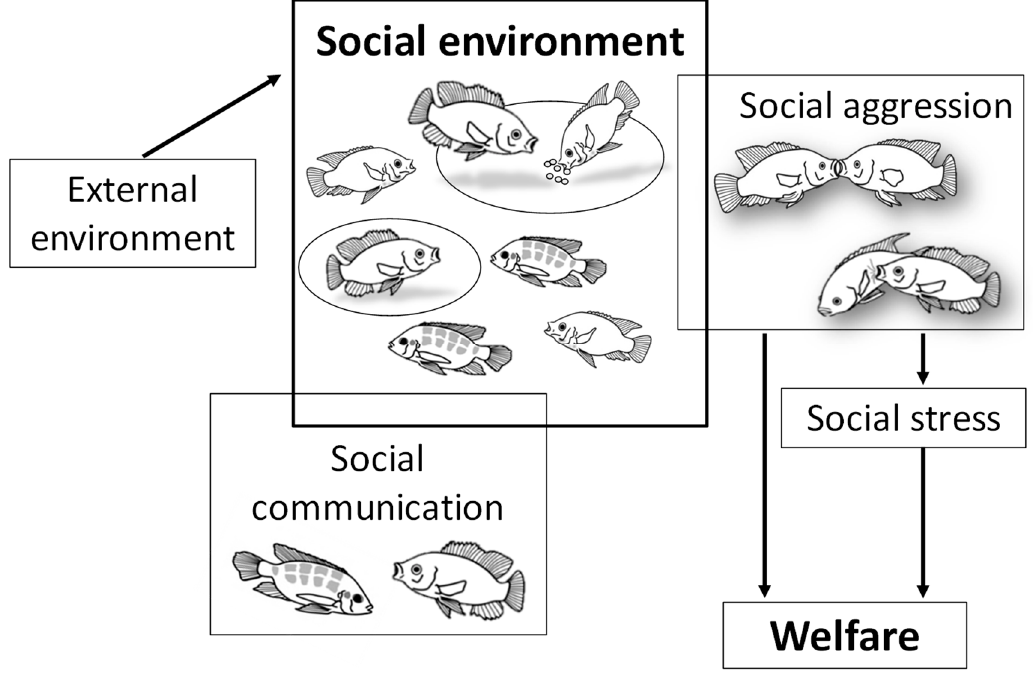
Figure 2. Summary of factors in artificial environment that would affect Nile tilapia’s social behavior. For instance, light intensity, color, water renewal, grading for size, stocking density, and any other management that directly affects social communication. When such changes increase aggressive interactions, the welfare will be impaired by increased social stress levels and other effects from fighting, such as body injuries and very high energy expenditure. In summary, everything that affects social environment will affect welfare as well.